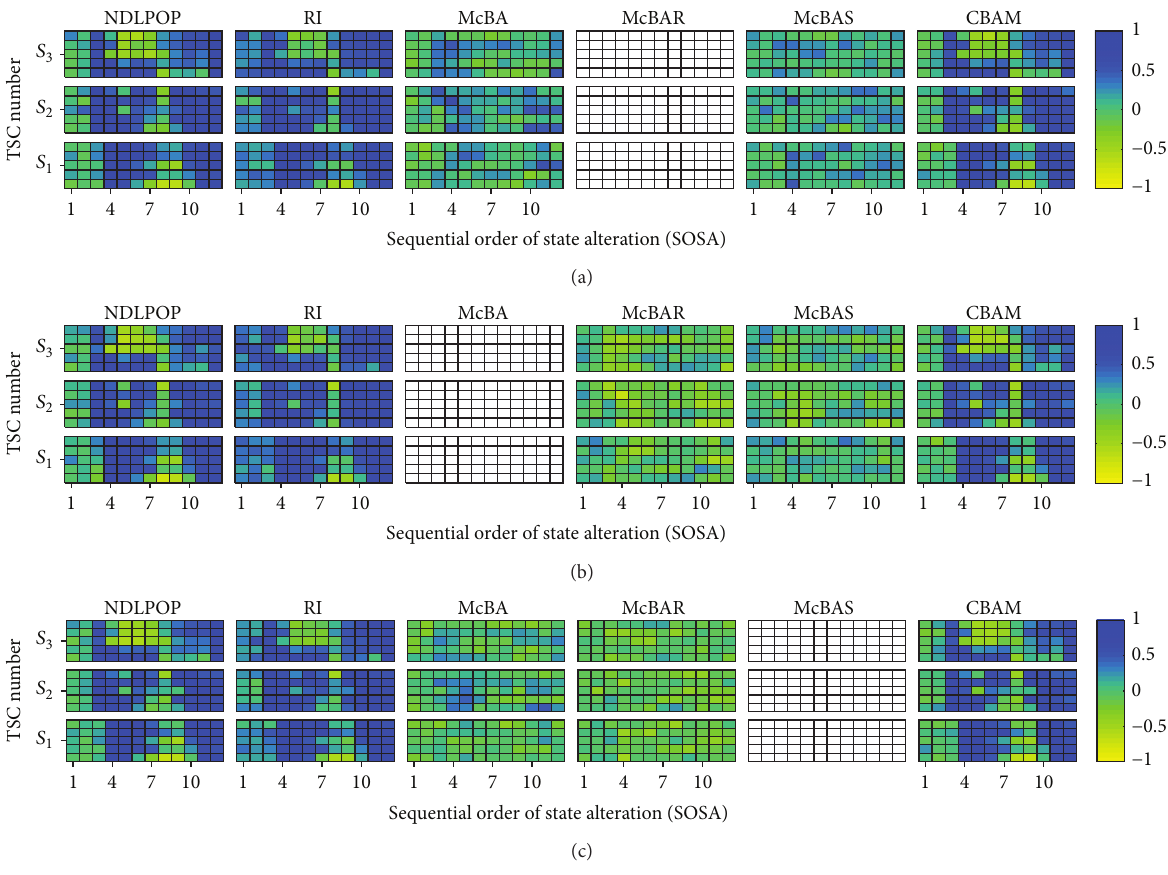
Figure 11: Dynamics of E 𝜎 𝑗,𝑘 [⋅] with 𝛿 = 6.0 with (a) McBAR, (b) McBA, and (c) McBAS as basis techniques.